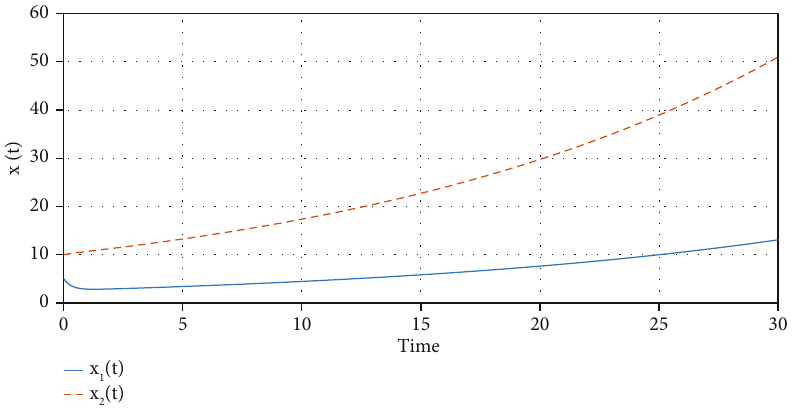
Figure 1: State response of the fi rst